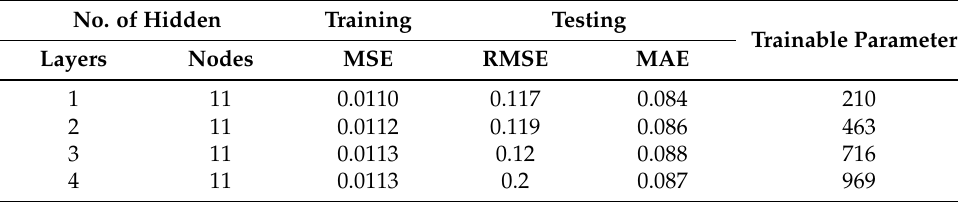
Table 9. Impact of hidden layers on the performance of the model “RHM-2”. No. of Hidden